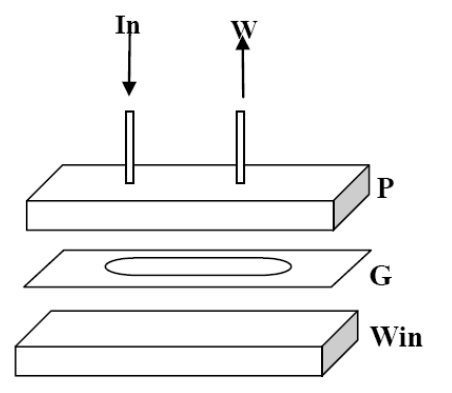
Figure 1. Flow cell design. In: carrier solution feed; W: waste; P: Plexiglas plate with immobilized cells; G: Gasket, 2mm thickness, 0.8cm 2 area; Win: optical window from Plexiglas or Quartz (PMT detector is opposite). Dimensions after assembly: 2 cm × 1 cm × 1 cm. Internal volume of flow cell is 160